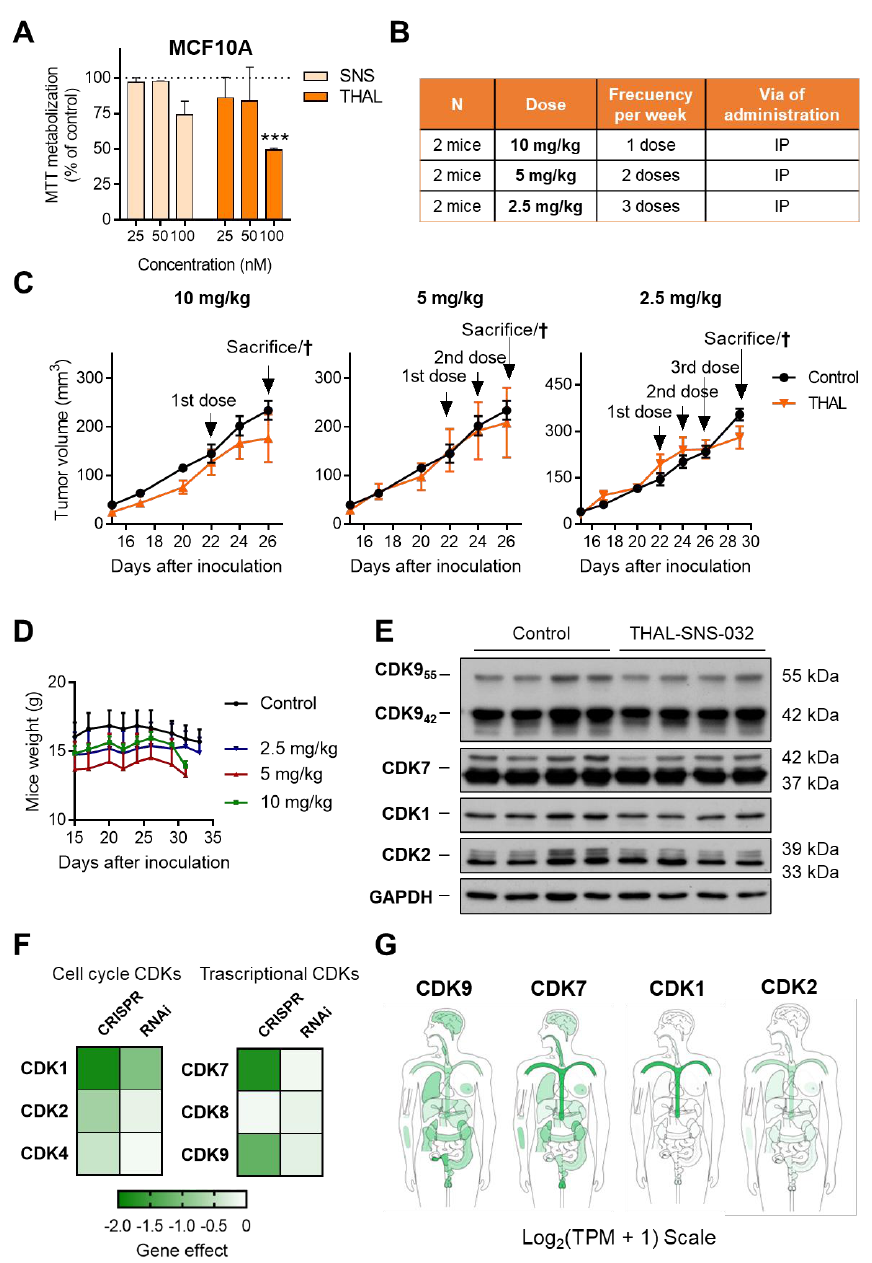
Figure 6. THAL-SNS-032 therapeutic index exploration. Normal breast cancer cell line MCF10A was treated with 25, 50, and 100 nM of SNS-032 and THAL-SNS-032. Proliferation was evaluated by MTT assay after 72 h of treatment ( A ). Table summary of THAL-SNS-032 doses, frequency, and route of administration in in vivo studies ( B ). Mice engrafted with BT474 cells were treated with THAL-SNS-032 (at indicated doses, I.P.) and controls with excipient. Mean of tumor volume ± SEM at each point was represented. Day of dose administration and sacrifice are indicated in each graph ( C ). Mice weight during the in vivo experiments. Treated mice (specially 10 mg/kg and 5 mg/kg) lost weight after THAL-SNS-032 administration ( D ). Western blot showing the expression levels of CDKs in tumors treated or untreated with THAL-SNS-032 ( E ). Heat map of the dependency score obtained by DepMap to evaluate CDKs dependency after CRISPR (DepMap 21Q3 Public + Score, CERES) or RNAi (Achilles + DRIVE + Marcotte, DEMETER2) inhibition ( F ). Body map showing expression of CDK9, CDK7, CDK1, and CDK2 in normal tissues in Log2(Transcript Per Million + 1) Scale. Adapted from: GEPIA2 web server (Gene Expression Profiling Interactive Analysis. http://gepia2.cancer-pku.cn/, accessed on 27 May 2021) ( G ). *** p <